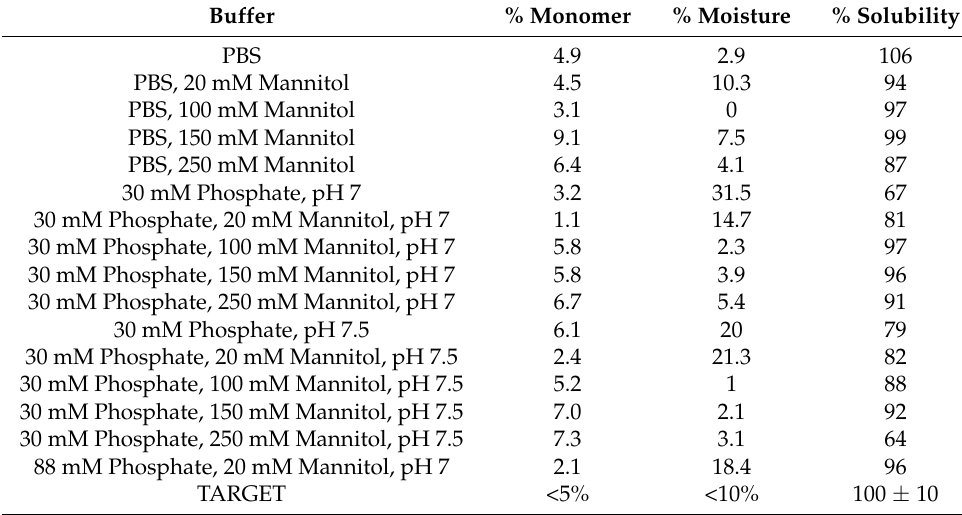
Table 1. Determination of optimal buffer excipient for EPT powder